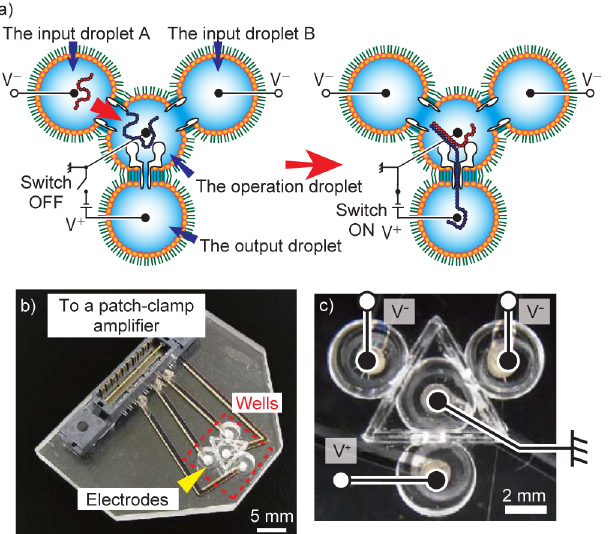
Fig 4. A schematic view of the four-well chip, the device used for the four-droplet network. (a) A four- droplet network for Negative-AND operation. Input (1, 0) was selected as an example. The input DNA strands were injected into the input droplets and the C DNA strands were prepared in the operation droplet. (b) An overall view of the 4WC. The electrodes in the wells were connected to a patch-clamp amplifier. (c) The wiring to the four wells. The electrodes were embedded on the bottom of the